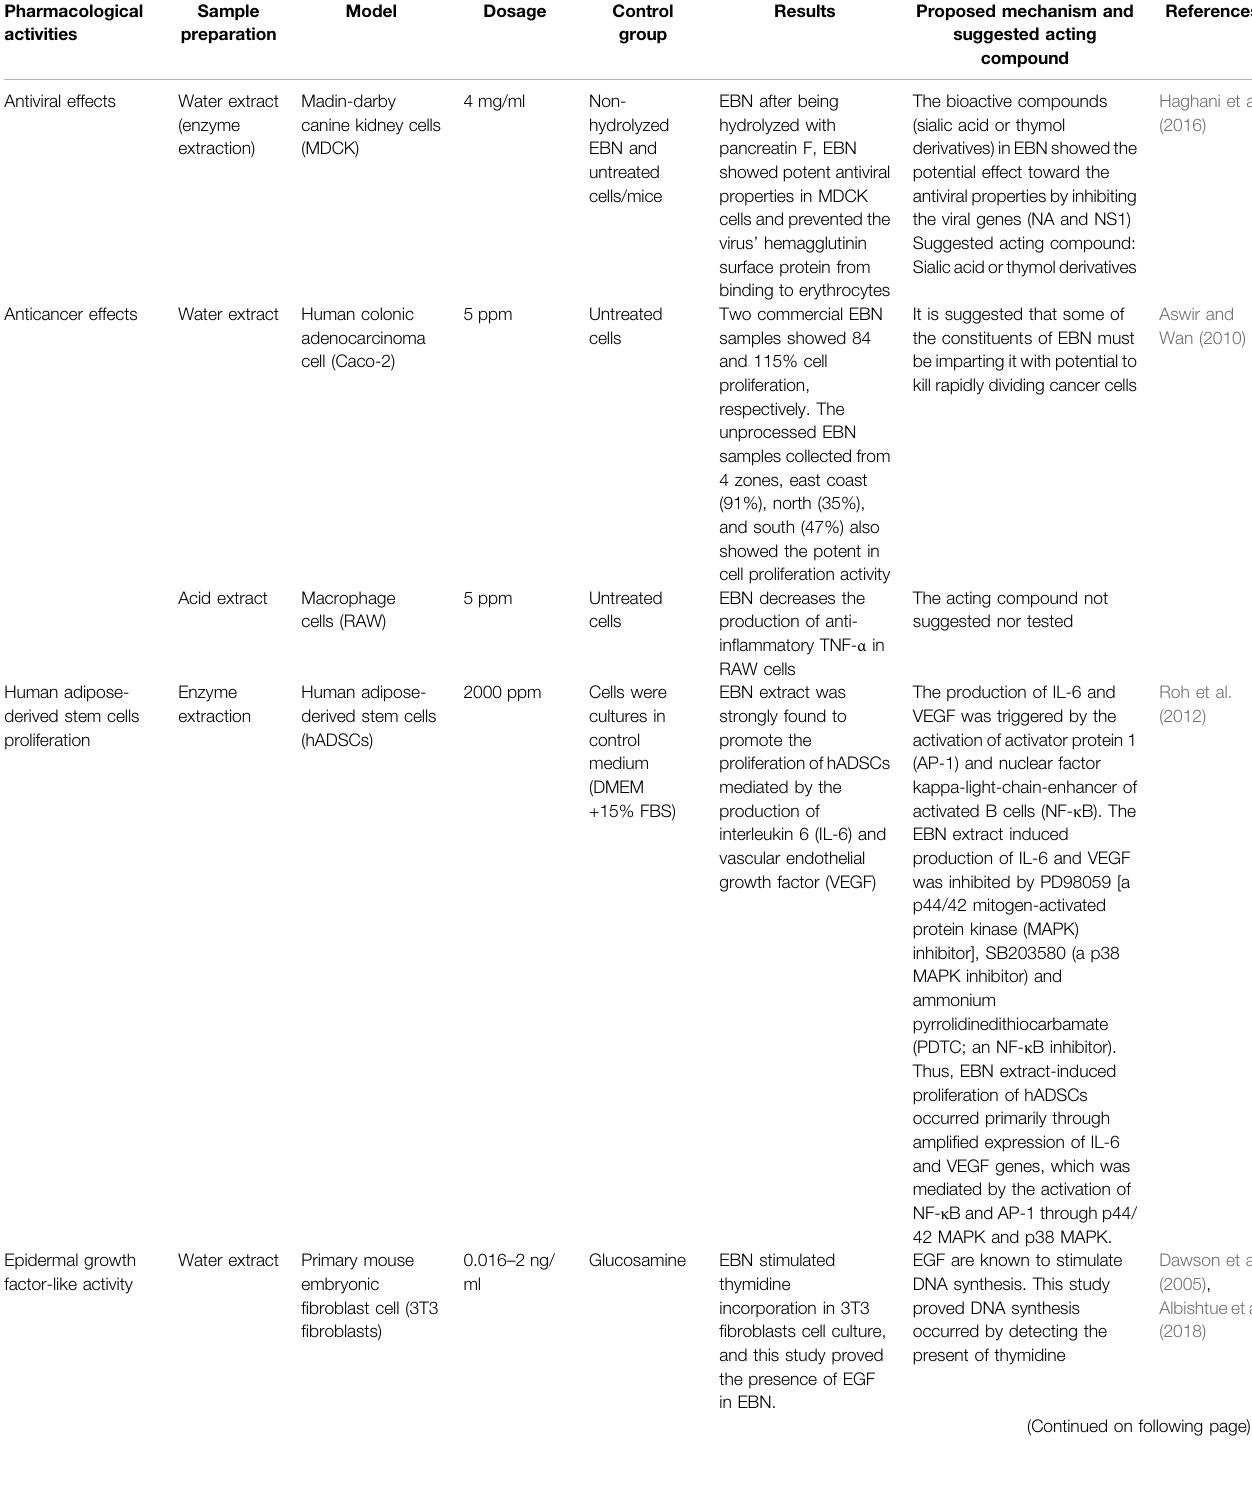
TABLE 1 | Summary of studied effects using EBN